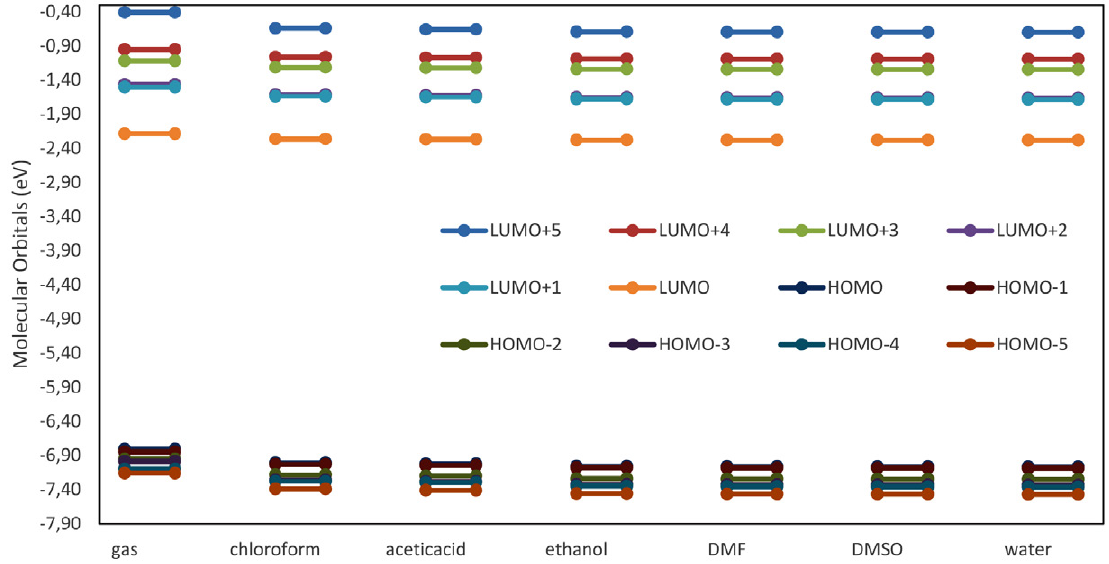
Figure 2. Frontier orbital energies for